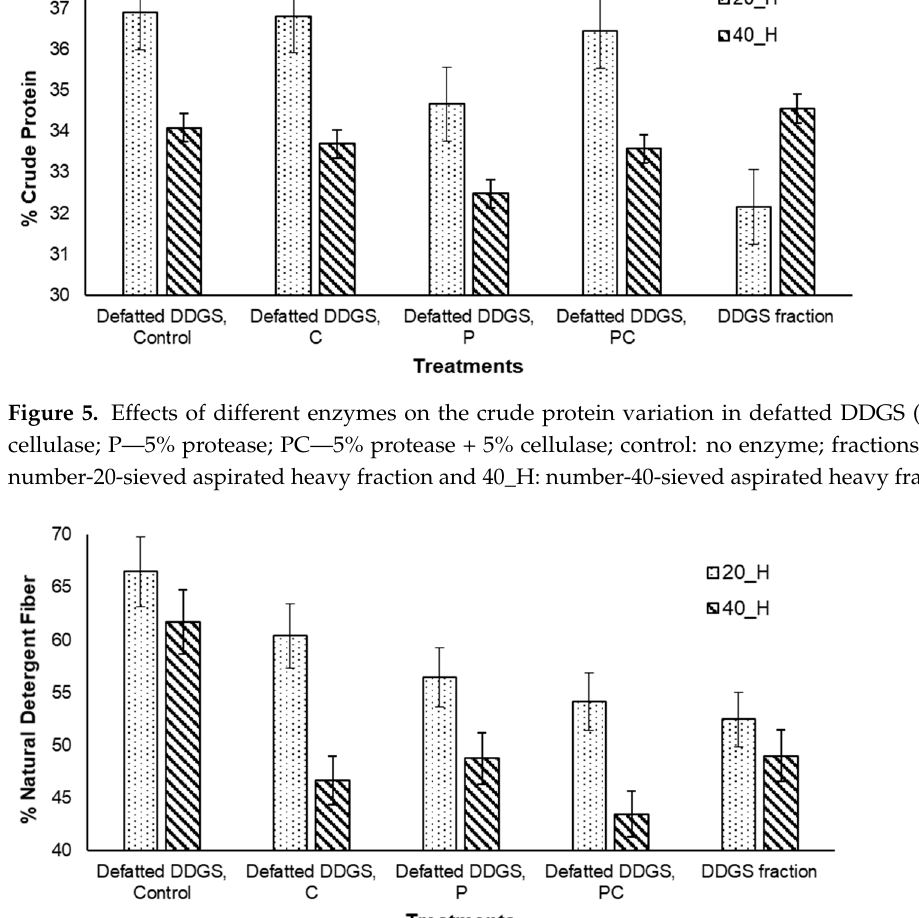
Figure 7. Effects of different enzymes on the ADF variation in defatted DDGS (C—5% cellulase; P— 5% protease; PC—5% protease + 5% cellulase; control: no enzyme; fractions, 20_H: number-20- sieved aspirated heavy fraction and 40_H: number-40-sieved aspirated heavy fraction). Figure 5 shows that crude protein is reduced in the heavy fractions of the number- 40-sieved aspirated sample compared to the number-20-sieved aspirated heavy fraction. The percent crude protein amount ranges from 32 to 37% regardless of the treatments. More crude protein was observed in the number-20-sieved aspirated heavy fraction than the number 40 sample due to enzyme activity. Particle size plays an important role here. More protein may be hydrolyzed in the small-particle-size DDGS compared to large-par- ticle-size DDGS. However, this did not have any effect on the oil recovery from these frac- tions. Proper crude protein levels are essential for the many types of livestock that rely on them for nutrition. When the percentage of CP is low, the bacteria responsible for diges- tion cannot sustain adequate levels to process forage. Ultimately, the animal’s intake and digestibility are reduced. Therefore, enzyme treatments (including control; heat treatment only) in number-20-sieved aspirated heavy fraction DDGS did improve crude protein per- cent of the defatted DDGS. For NDF content (Figure 6), the heavier fraction of aspirated numbers, 20 and 40 DDGS has less NDF than the control treatment. Reduced NDF is observed (except control) in the number-40-sieved aspirated heavy fraction after the enzymatic hydrolysis. How- ever, the opposite trend is followed in the number-20-sieved aspirated heavy fraction after the enzymatic hydrolysis. No enzyme treatment (control) leads to a very high NDF